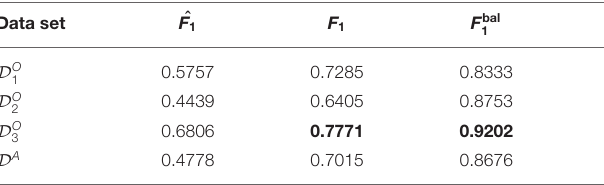
TABLE 6 | The results of the ensemble classification heuristic (Experiment D): Average ˆ F 1 and F 1 scores obtained from testing an ensemble of three networks trained in the 1 vs. 1 study applied to the complementary fourth data set.